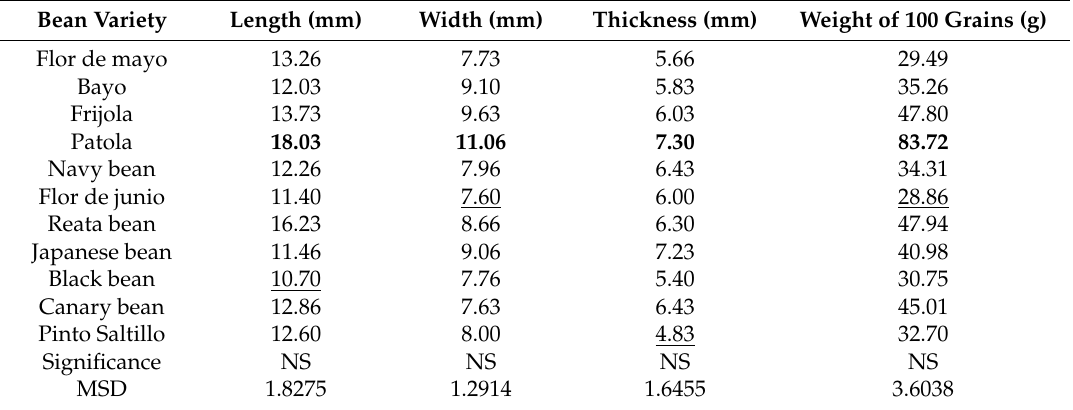
Table 3. Biodiversity of bean varieties grown in the state of Zacatecas, Mexico (physical characteristics). Bean Variety Length (mm) Width (mm) Thickness (mm) Weight of 100 Grains (g) Flor de mayo 13.26